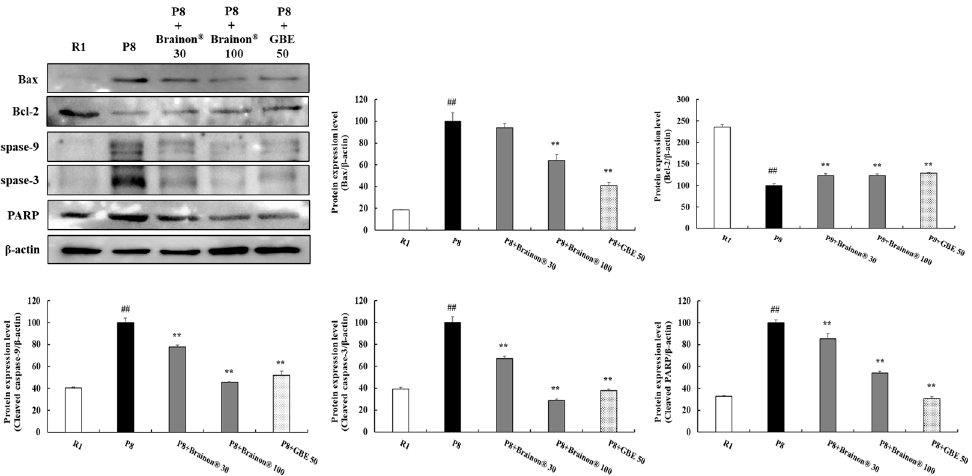
Figure 8. Brainon ® inhibits apoptosis-related proteins in the cerebral cortex of SAMP8 mice. Bax (20 kDa), Bcl-2 (26 kDa), cleaved caspase-9 (35 kDa), cleaved caspase-3 (17–19 kDa), and cleaved PARP (89 kDa) protein levels were analyzed using Western blotting. The density of each protein band was measured using the ImageJ program. Protein was normalized with β -actin (45 kDa). Values are presented as mean ± SD ( n = 3). ## p < 0.01 vs. R1 (SAMR1) group; ** p < 0.01 vs. P8 (SAMP8) group.